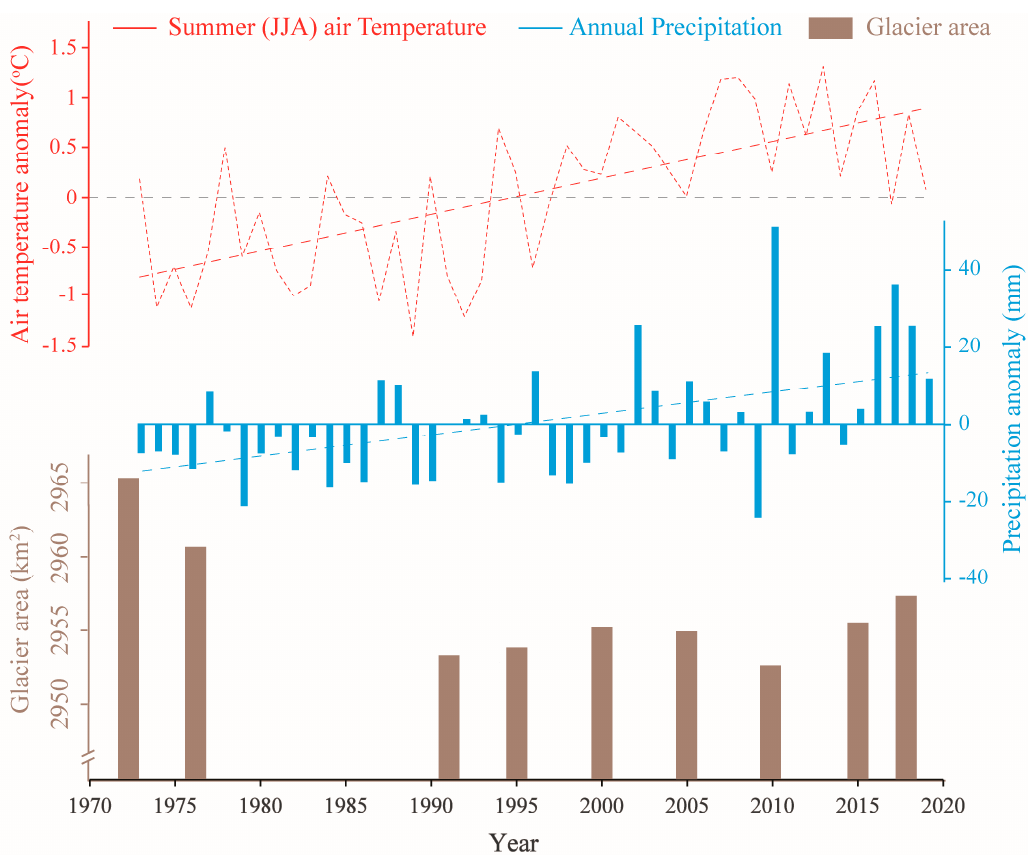
Figure 8. Changes in mean annual precipitation and mean summer air temperature (June, July and August) based on the six nearest weather stations around the WKL as anomalies from the mean between 1973 and 2019. The red and blue dashed lines are the linear trend lines of air temperature and precipitation.